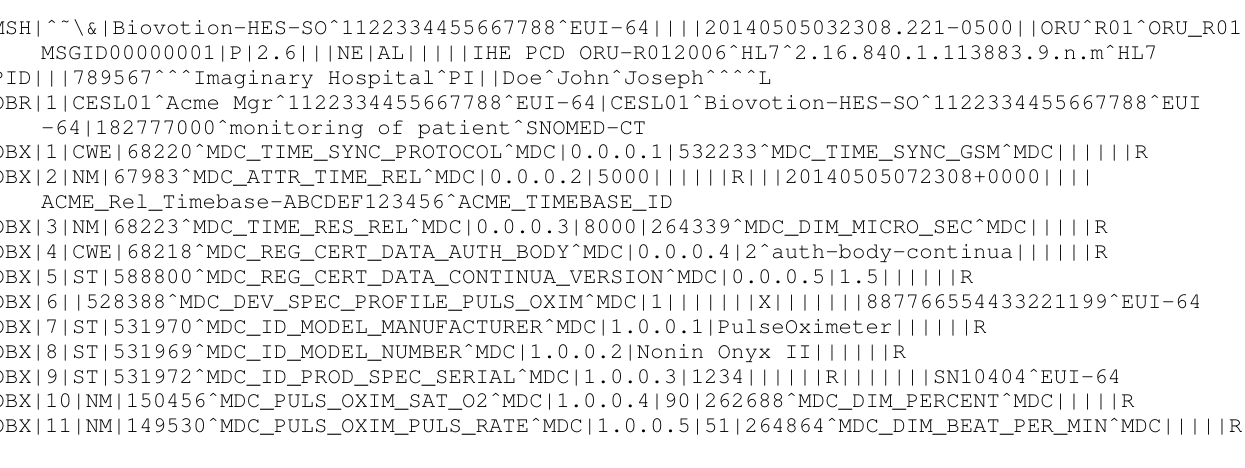
Fig. 3: HL7 V2.6 message using the IHE PCD profile of a pulse oximeter (IEEE 11073-10404 [6]) spot measurement.